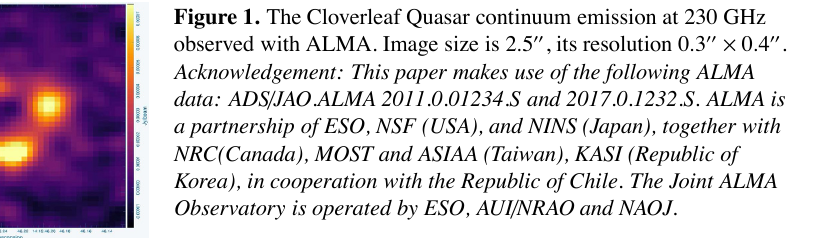
Figure 1. The Cloverleaf Quasar continuum emission at 230